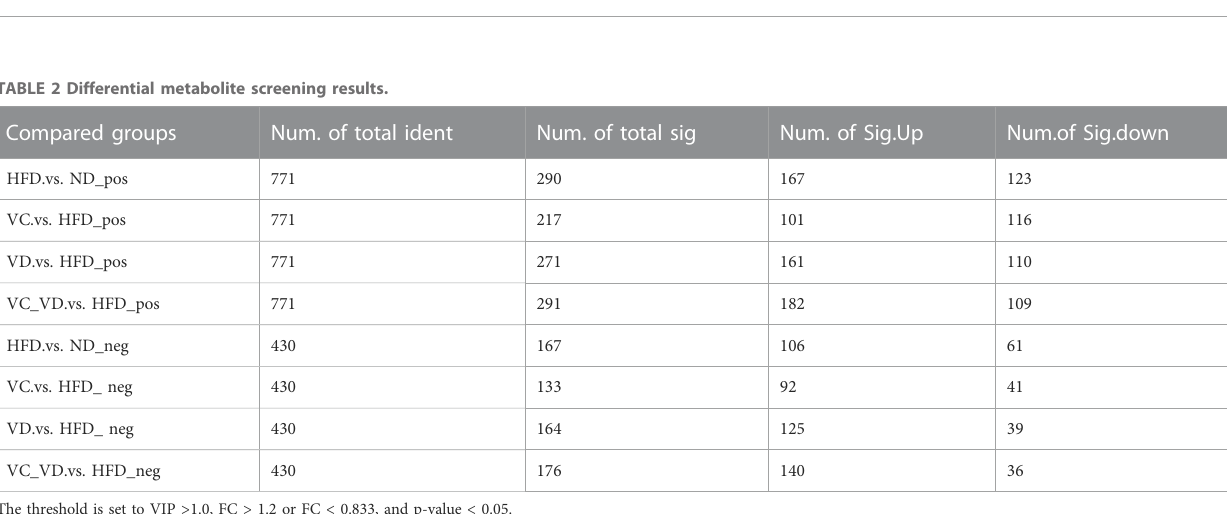
(140 upregulated and 36 downregulated) (Figure 6J, right panel).